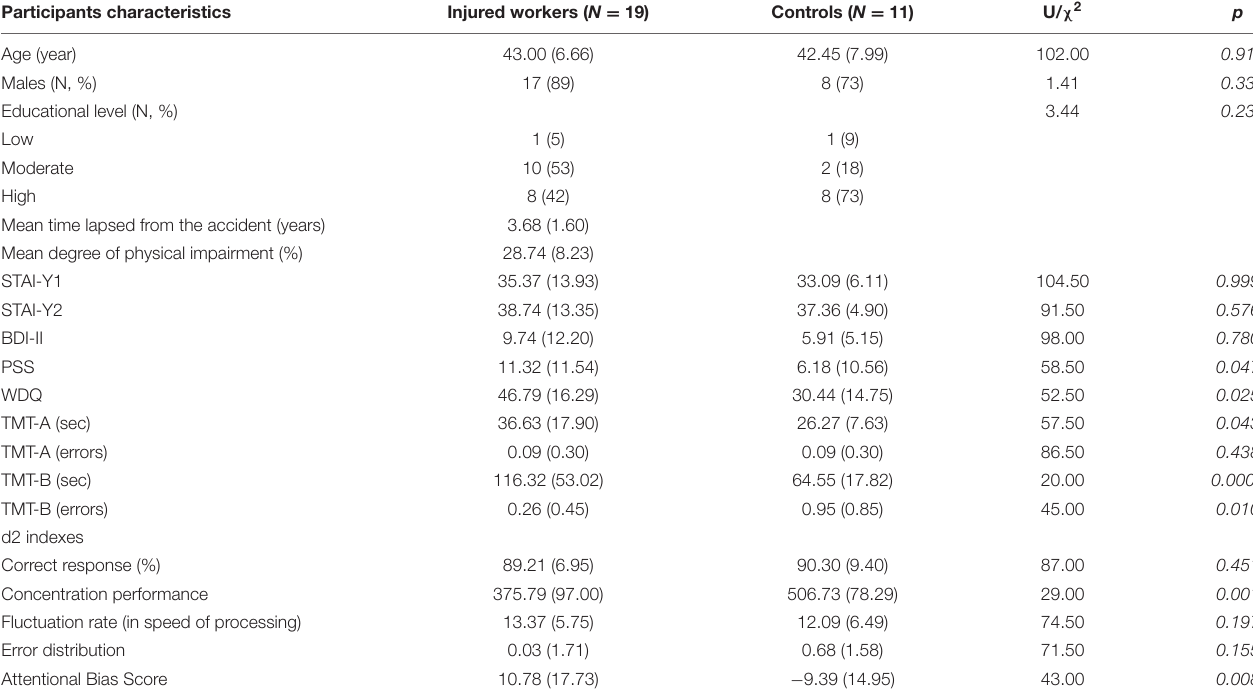
The gender ratio in our sample of injured workers (89% male) fairly matched the gender distribution of work-related injuries in the European and Italian populations (78.5 and 79.6%, respectively; Eurostat, 2017). TABLE 1 | Socio-demographic characteristics, questionnaire scores, cognitive tests and Attentional Bias Score comparison between Injured workers and Controls. Participants